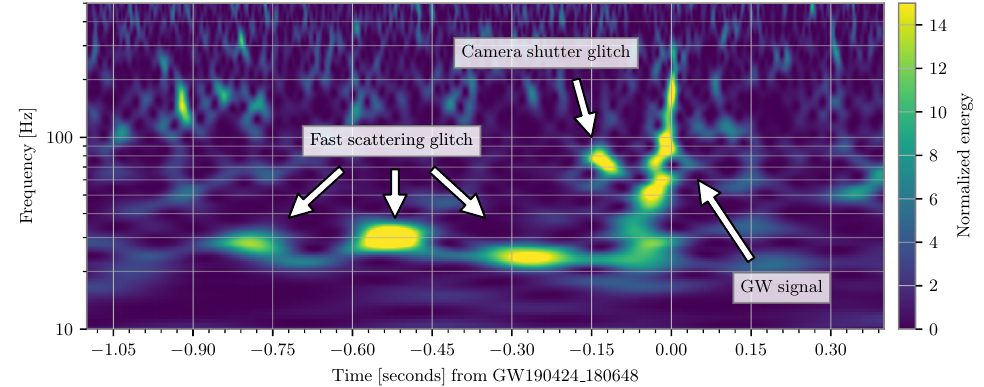
Figure 7. An example of a gravitational-wave signal (GW190424_180648) with two different types of glitches also present nearby in the data. Event validation procedures were able to identify the source of both glitches as well as confirm that there was no evidence the gravitational-wave signal was an instrumental artifact. The source of one of the glitches was vibrations from an automated camera shutter that was inadvertently left running in one of the detector end stations [18] while the source of the second is light scattered off of the main laser beam path that reflects and then interferes with the main beam (referred to as “fast scattering”) [46]. This example highlights that it is possible to detect and analyze a gravitational-wave signal despite the presence of nearby glitches. Data plotted is from LIGO Livingston and accessed via GWOSC